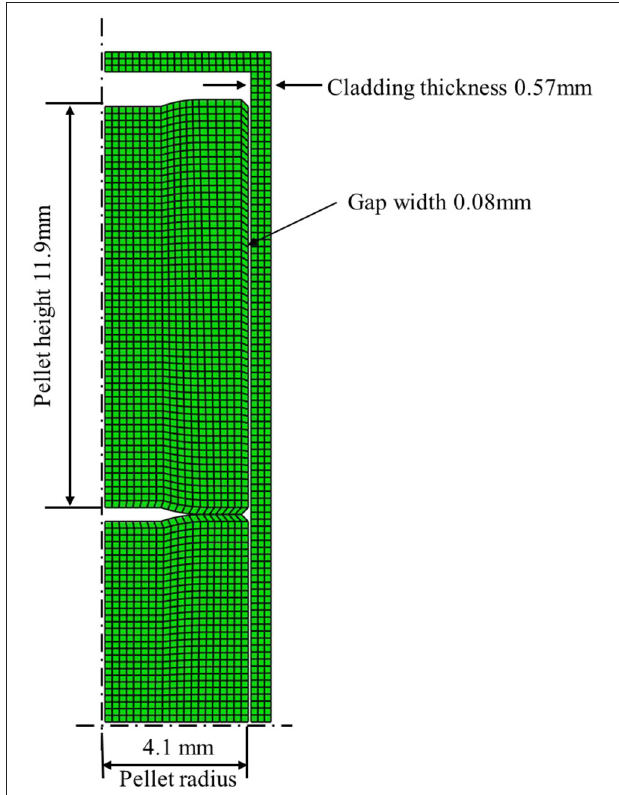
FIGURE 3 | The geometry and the mesh of the fuel rod.